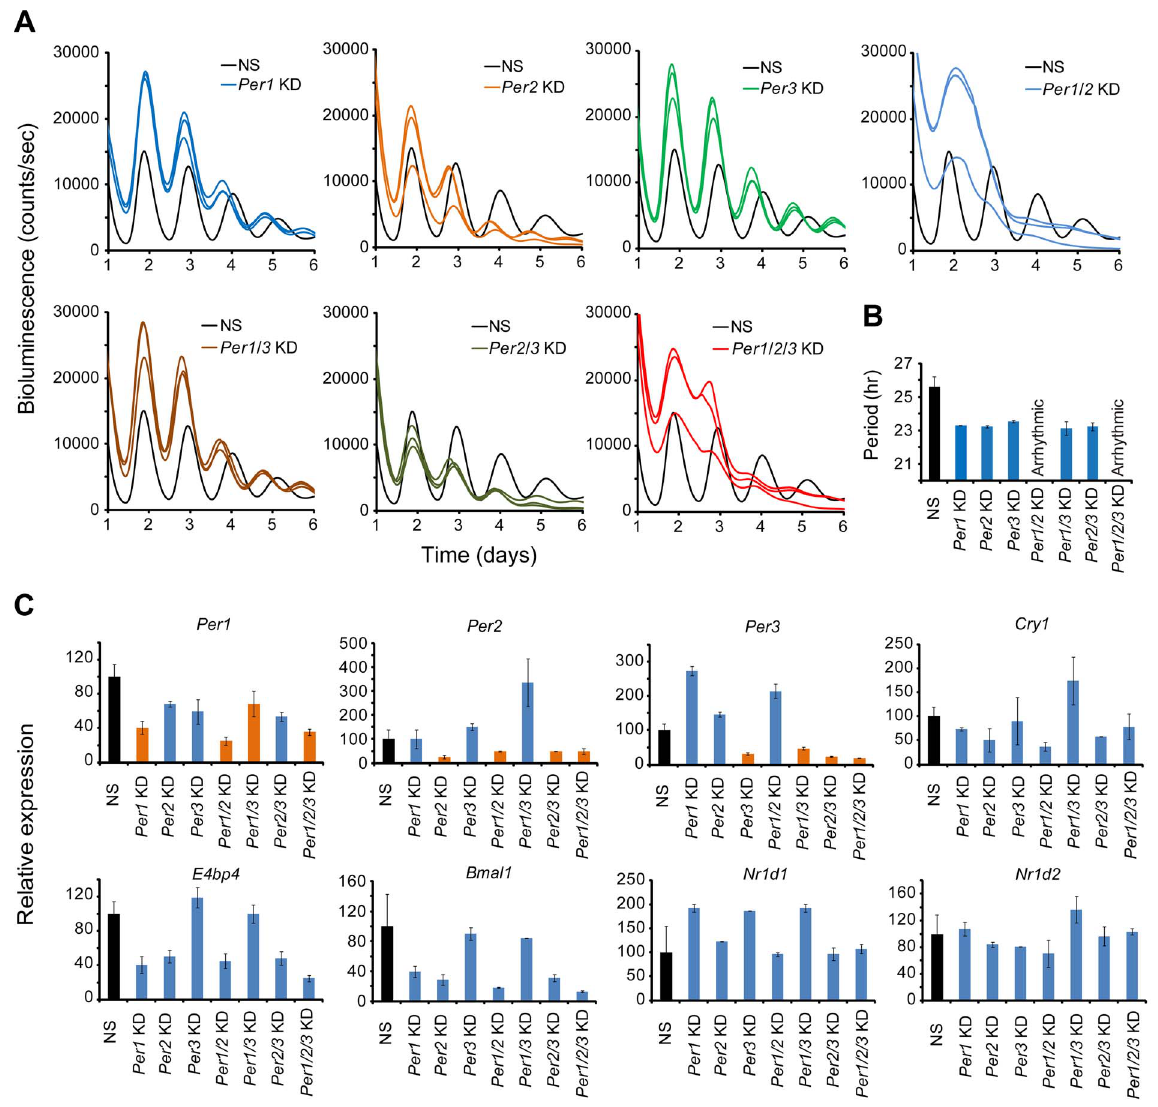
Figure 5. shRNA-mediated single and composite knockdown effects of Per1 , Per2 and Per3 in MMH-D3 hepatocytes. (A) Representative bioluminescence expression patterns recorded on LumiCycle upon knockdowns of Per1 , Per2 , Per3 (single KD); Per1 / Per2 , Per1 / Per3 , Per2 / Per3 (double KD); and Per1 / Per2 / Per3 (triple KD) in MMH-D3 hepatocytes. sh62, sh67 and sh74 were used to knock down Per1 , Per2 and Per3 , respectively. All single KDs led to short periods in all three cell types, consistent with Synergy assays. Per1 / Per2 double and Per1 / Per2 / Per3 triple KDs caused arrhythmicity. All other double composite KDs caused short period phenotype. (B) Summary of period length phenotypes. Data are mean 6 SD (n=3 independent samples/wells from one experiment). NS, non-specific shRNA. Compared to NS controls, significant difference in period length was detected (NS vs. Per1 KD, t-test, p , 0.001; NS vs. Per2 KD, t-test, p , 0.001; NS vs. Per3 KD, t-test, p , 0.001; NS vs. Per1 / Per3 KD, t-test, p , 0.001; NS vs. Per2 / Per3 KD, t-test, p , 0.001). (C) qPCR analysis of clock gene expression upon Per KD in non-synchronized MMH-D3 cells. Values for each gene are expressed as percentage of gene expression in NS control cells. Data represent two samples/wells from one experiment.